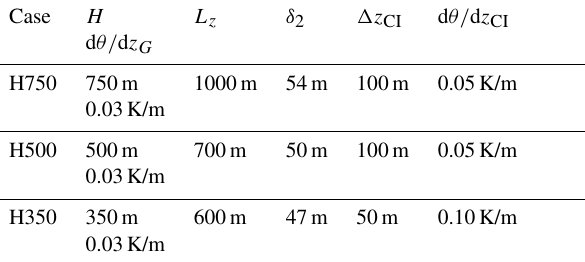
Table 1. Characteristics of the considered atmospheric boundary layers and of their capping inversions. L z denotes the height of the simulation domain and δ 2 the (streamwise) momentum